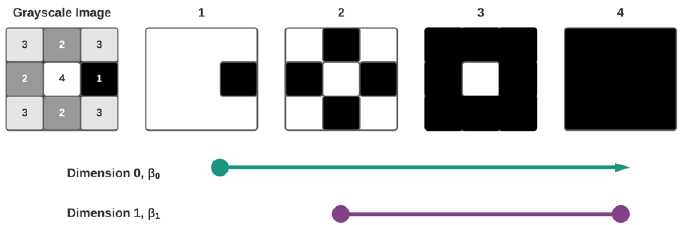
Figure 5. Induced filtration of a 3 × 3 grayscale image matrix and the correspondent barcode for β 0 and β 1 . Using a luminescence depth of 4 elements, 𝐿 = {1,2,3,4} , to simplify the example.